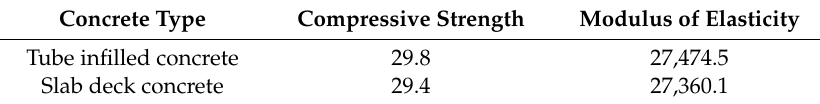
Table 3. Material properties of steel components (units : N/mm 2 , μm/m).